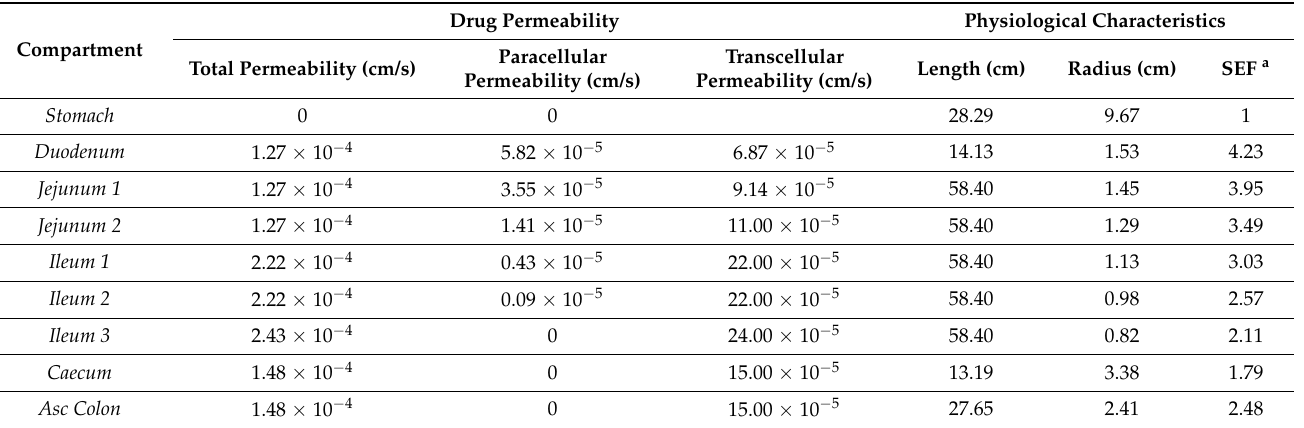
Table 5. In-silico estimated segmental-dependent paracellular and transcellular minoxidil permeabil- ities, and relevant characteristics of the human GI